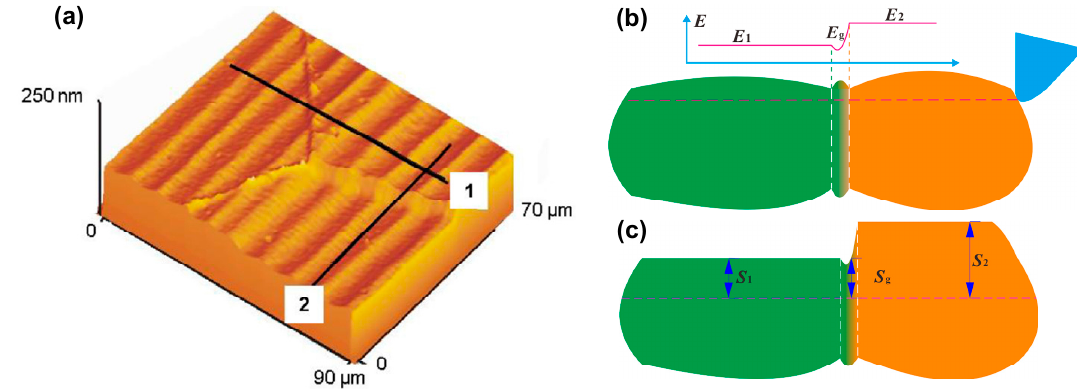
Figure 9. The step structure on the diamond turned of polycrystalline copper and its theoretical explanation: ( a ) the surface topography of step structure on the machined surface; ( b ) surface and the distribution of Young’s modulus before cutting process; ( c ) the step structure formation on the machined surface. Reproduced with permission from [28,107].